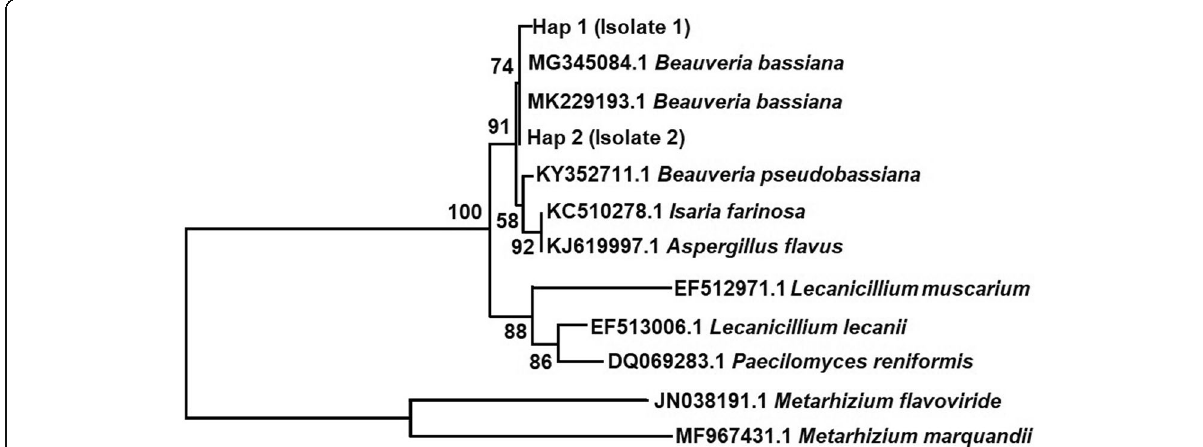
Fig. 2 Phylogenetic relationships between haplotypes of Beauveria bassiana samples in the Eastern Black sea area and other entomopathogenic fungal species. The analysis was based on the neighbor-joining algorithm using the Tamura-Nei genetic distance model, with bootstrap support estimated from 1000